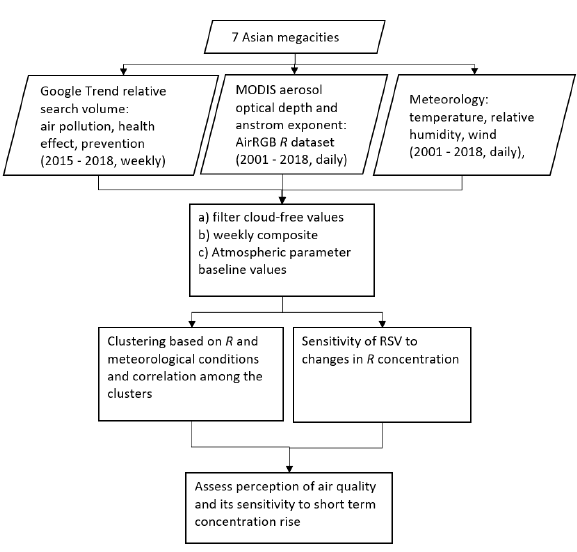
Figure 1. Flowchart studying relationship between Google Trends based search activity ( RSV ) and fine aerosol concentration